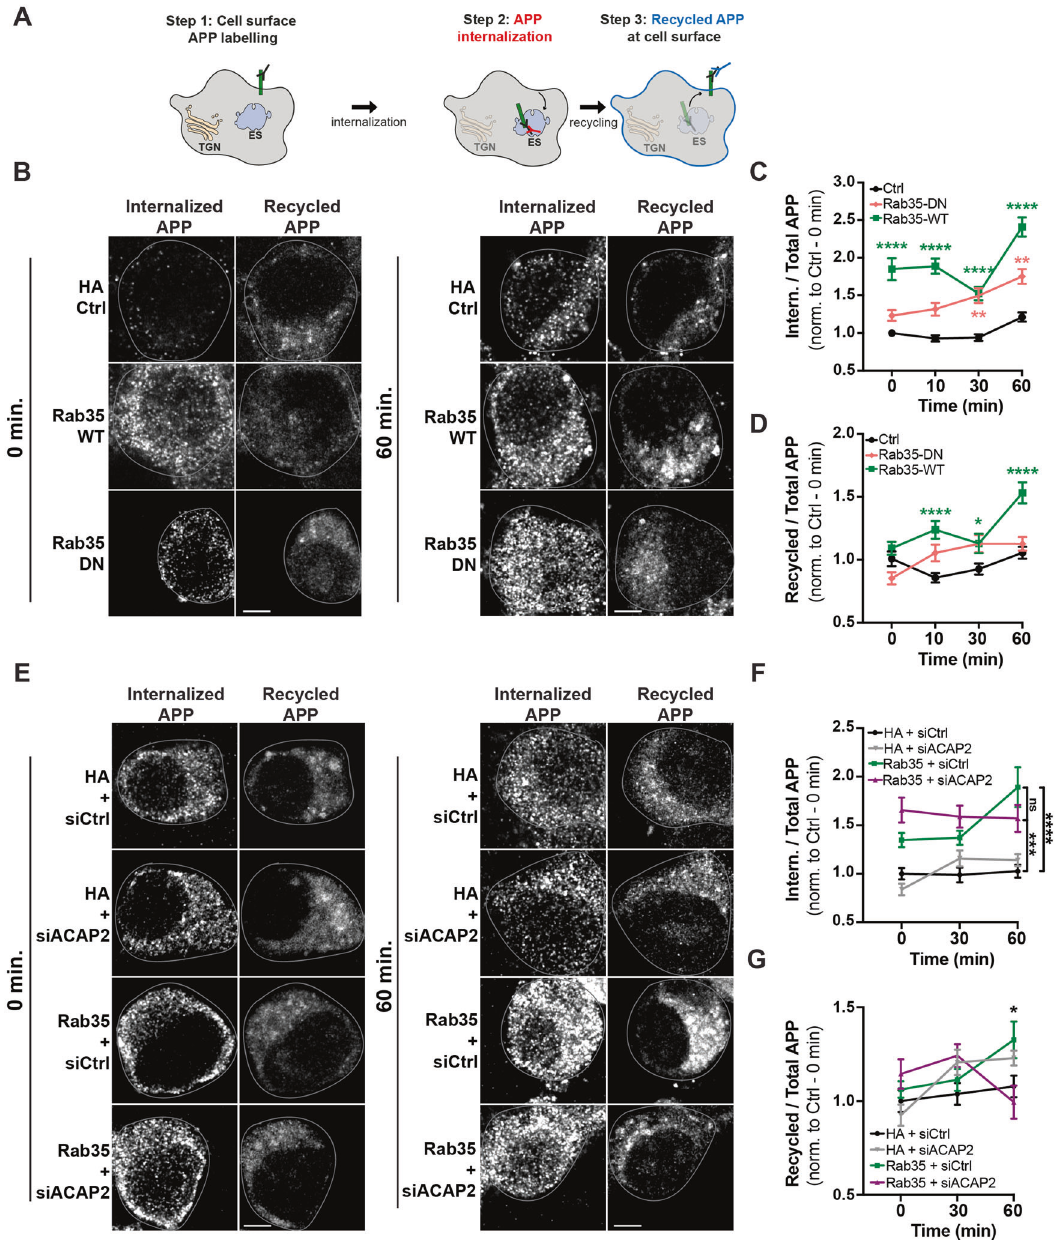
Fig. 5 Rab35 stimulates APP recycling to the plasma membrane via ACAP2. A Schematic representation of the APP recycling assay, in which APP internalization and recycling were assessed by labeling cell-surface APP with 22C11 antibody followed by cell incubation for 0, 10, 30, or 60 min, and fi xation and immunostaining with secondary antibodies to detect recycled or internalized APP. B – D Representative images and quanti fi cation of APP internalization and recycling in N2a cells expressing APP-GFP and either HA control, HA-Rab35 WT, or HA-Rab35 DN. Internalized and recycled APP are shown at 0 and 60 min time points post-labeling, with cells outlined in gray (* P WT-30min = 0.0299, ** P DN-30min = 0.0027, ** P DN-60min = 0.0017, **** P < 0.0001, 2-way ANOVA and Sidak post-hoc analysis, n = 53 – 269 cells per condition/ timepoint, 2 – 5 experiments. For APP internalization: Time × Rab35 interaction F 6,1897 = 3.002, P = 0.0064, overall Rab35 effect F 2,1897 = 118.9. For APP recycling: Time × Rab35 interaction F 6,1897 = 3.443, P = 0.0022, overall Rab35 effect F 2,1897 = 26.03). E – G Representative images and quanti fi cation of APP internalization and recycling in N2a cells expressing APP-GFP and either HA or HA-Rab35, together with control siRNA (siCtrl) or siRNA to knockdown ACAP2 (siACAP2). Internalized and recycled APP are shown at 0 and 60 min time points post-labeling (for F *** P HA + siCtrl vs. Rab35 + siACAP2 = 0.0003, **** P HA + siCtrl vs. Rab35 + siCtrl < 0.0001, 2-way ANOVA and Tukey ’ s multiple comparisons test, n = 20 – 48 cells per condition/timepoint, three experiments. Time × Rab35 interaction F 4,310 = 2.843, P = 0.0244, overall Rab35/ACAP2 effect F 2,310 = 39.12, = 0.0457, P = 0.66, two-way ANOVA with Tukey ’ s multiple comparisons test, P < 0.0001. G * P HA + siCtrl vs. Rab35 + siCtrl HA + siCtrl vs. Rab35 + siACAP2 = 2.877, P = 0.023, overall Condition effect n = 20 – 48 cells per condition/timepoint, three experiments. Time × Condition interaction F 4,310 = 3.279, P = 0.039). Scale bars: 5 µm. All numeric data represent mean ± SEM. F 2,310